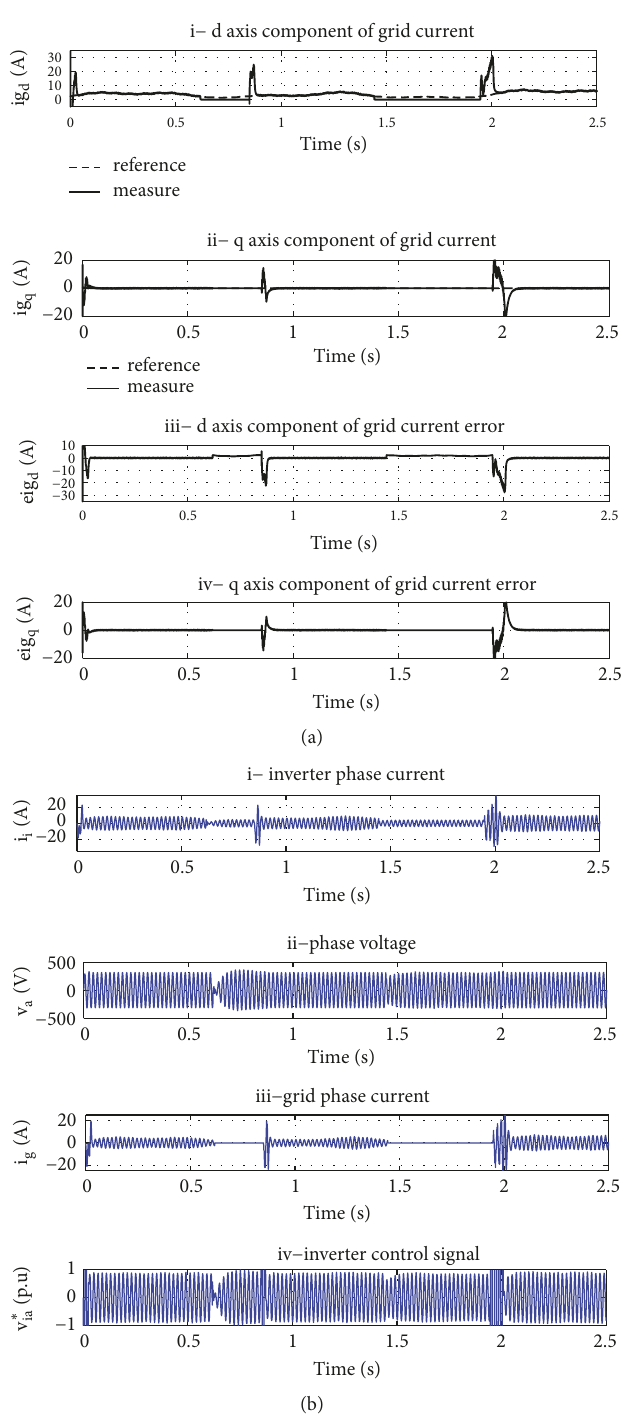
Figure 11: Performances of the grid side PI controllers in automatic switching mode. (a) d-axis grid current (i), q-axis grid current (ii), d-axis grid current error (iii), and q-axis grid current error (iv). (b) Inverter phase current (i), load phase voltage (ii), grid phase current (iii), and inverter control signal